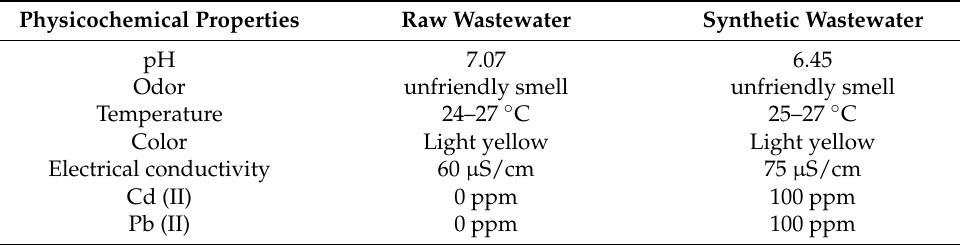
Table 1. Summary of physicochemical analysis of wastewater and synthetic wastewater. Physicochemical